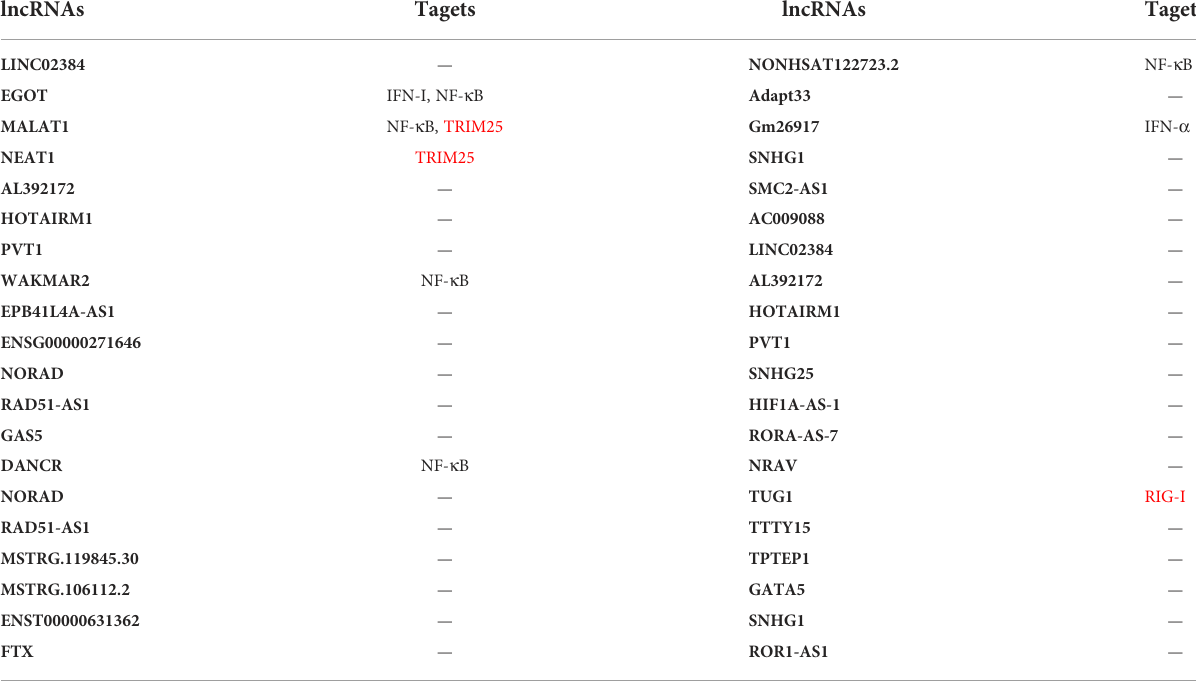
TABLE 1 Targets of lncRNAs in the RIG-I signaling pathway in COVID-19 infection. The targets we found in the ENCORI database are marked in red.